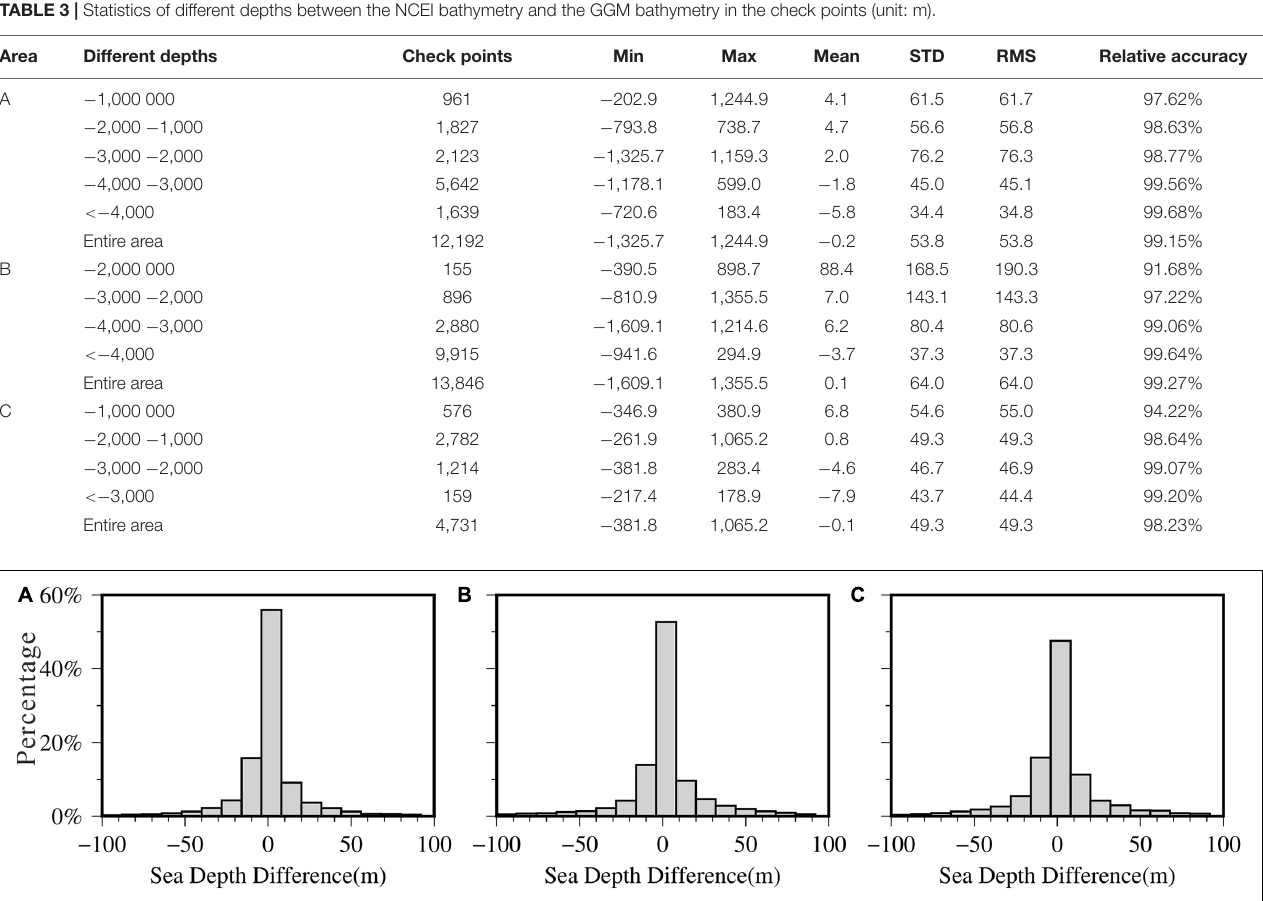
FIGURE 6 | Histograms of the differences between NCEI bathymetry and GGM-derived bathymetry in the check points. (A) Error statistics of test area A. (B) Error statistics of test area B. (C) Error statistics of test area C.